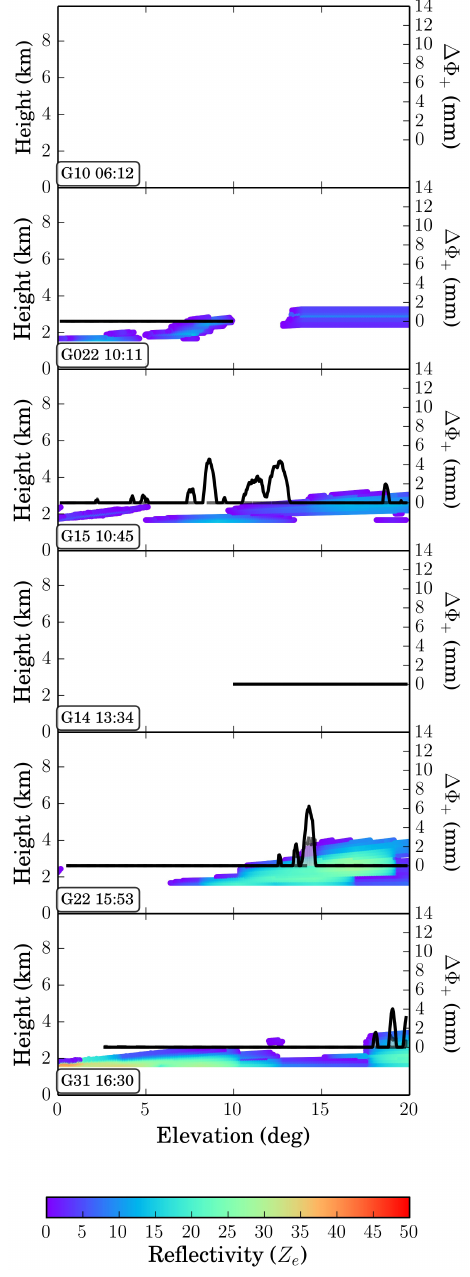
Figure 12. Same as Fig. 11 but for 9 July 2014. The signal in PRN G15 could not be explained by the model